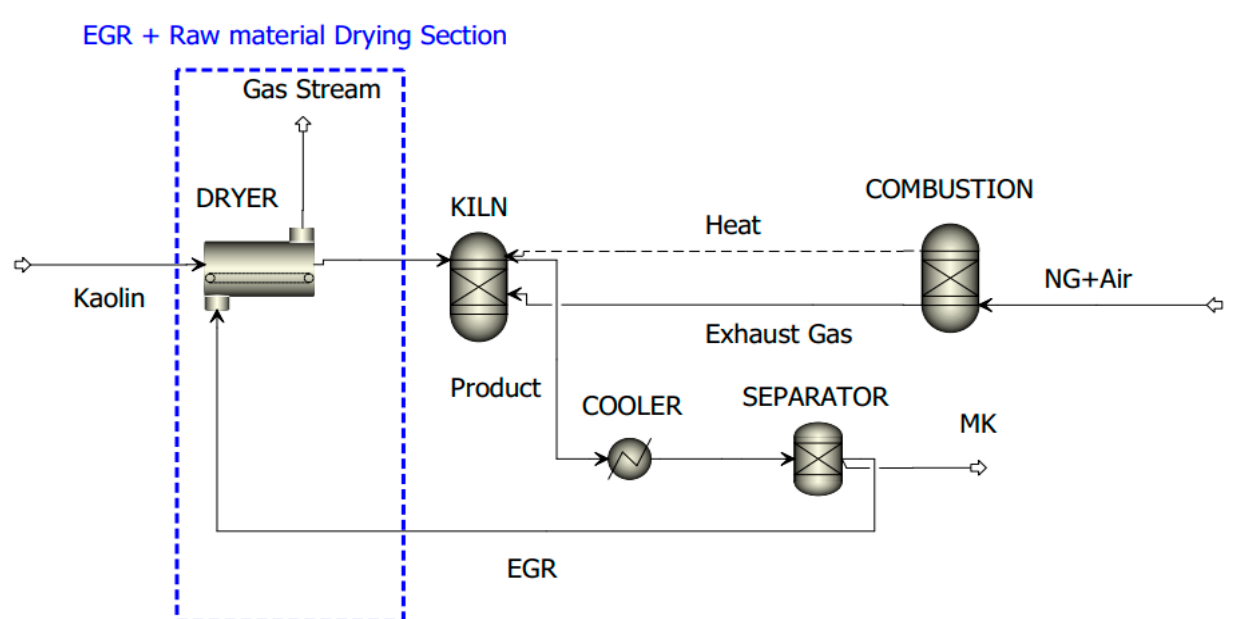
Figure 1. Process-model flowsheet for MK production. Baseline and MK-NG configuration (addi- tional components in blue dashed frame).